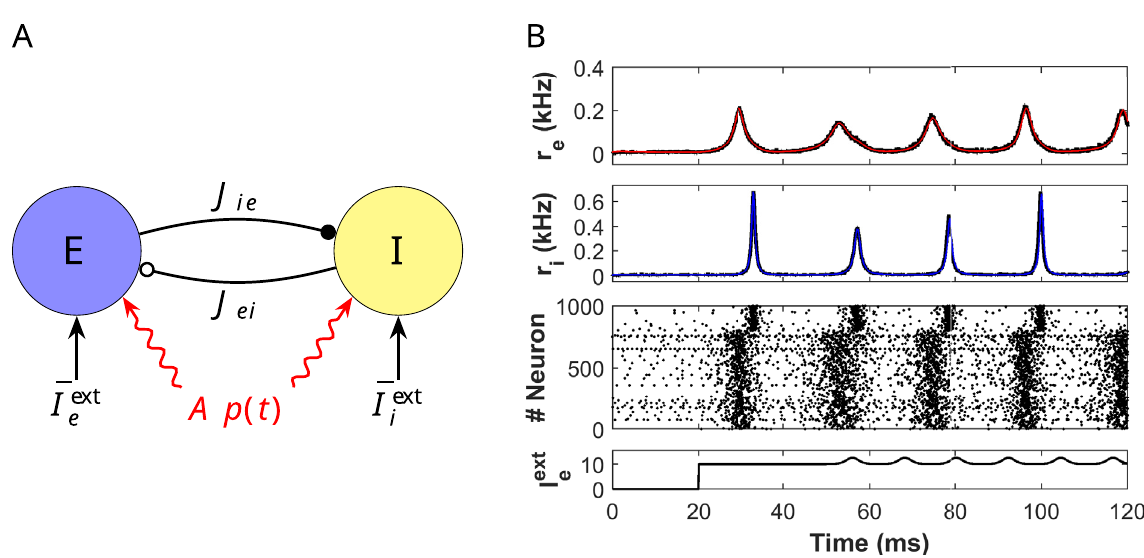
Fig 1. E-I cortical network and comparison between full network and reduced system. (A) Schematic representation of a cortical neural network consisting of excitatory (E) and inhibitory (I) cells. Excitatory (resp. inhibitory) synapses are depicted by arrows with a black-filled (resp. empty) circle pointing at the receiving population. The parameter J ab , a , b 2 { e , i } is the connectivity strength of the b ! a synapse. Besides synaptic input, each population also receives an external tonic current � I ext , a 2 { e , i }. Additionally, both populations receive a periodic a input Ap ( t ) (red curve), modeling the input from an oscillating neuronal population. (B) From bottom to top: Time evolution of the external input current I ext ð t Þ onto the E-cells. I ext ð t Þ ¼ 0 for 0 < t < 20, I ext ð t Þ ¼ 10 , for 20 < t < 50 and I ext ð t Þ ¼ 10 þ 0 : 8 p ð t Þ , with p ( t ) defined in (15) e e e e with κ = 2, T = T � /2 and T � = 24.234 ms. Raster plot of 1000 randomly selected neurons (the first 800 neurons are excitatory and the last 200 inhibitory). Time evolution of the macroscopic quantities r and r obtained from simulations of the mean-field model (1)-(2) (red and blue e i curves, respectively) and the averaged firing rate activity of the full spiking network (black). Notice that curves lie one on top of the other, showing perfect agreement. In the latter case, the mean firing rate has been computed by averaging the number of spikes in a time window of = N = 5000, � I ext ¼ 0 and the rest of the parameters as in (6). size δ t = 8 � 10 − 2 . Parameters: N e i i